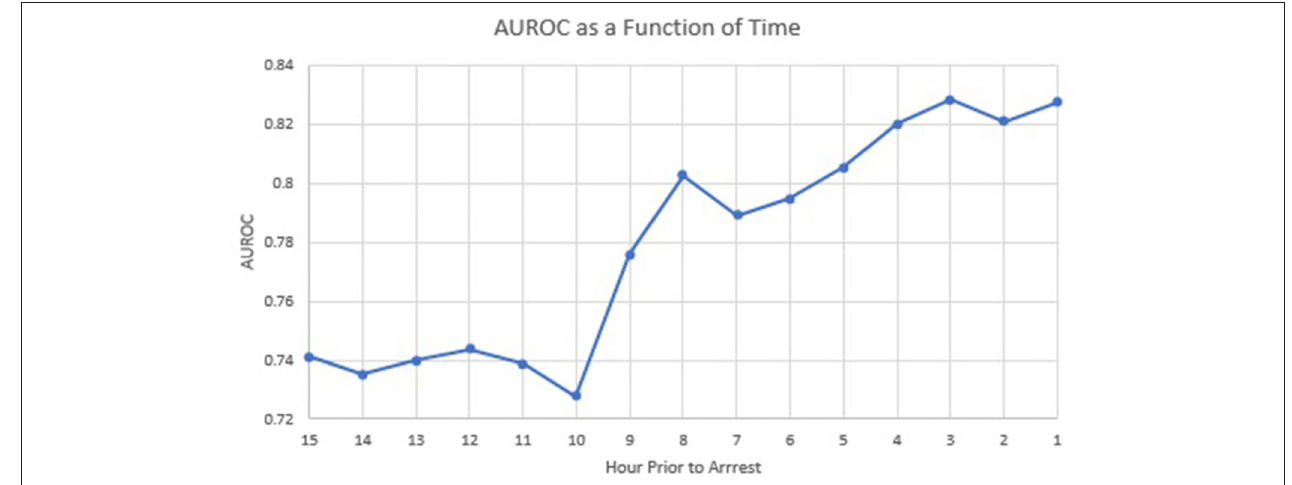
FIGURE 1 | Multivariable model prediction of cardiac arrest.